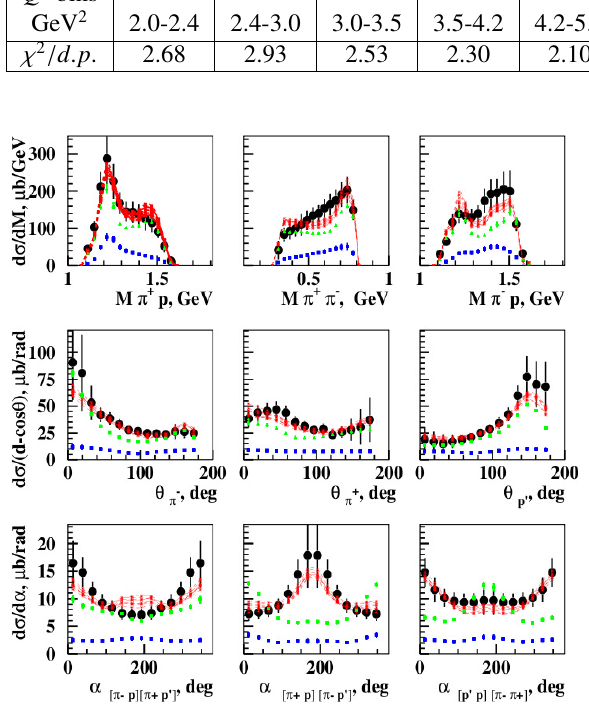
Figure 1. (Color online) Representative example of 1-fold di ff erential cross sections (points with error bars) and the resonant / non-resonant contributions (blue / green bars) from the fits (red curves) of the CLAS π + π − p photoproduction data at W from 1.73 GeV to 1.75 GeV.